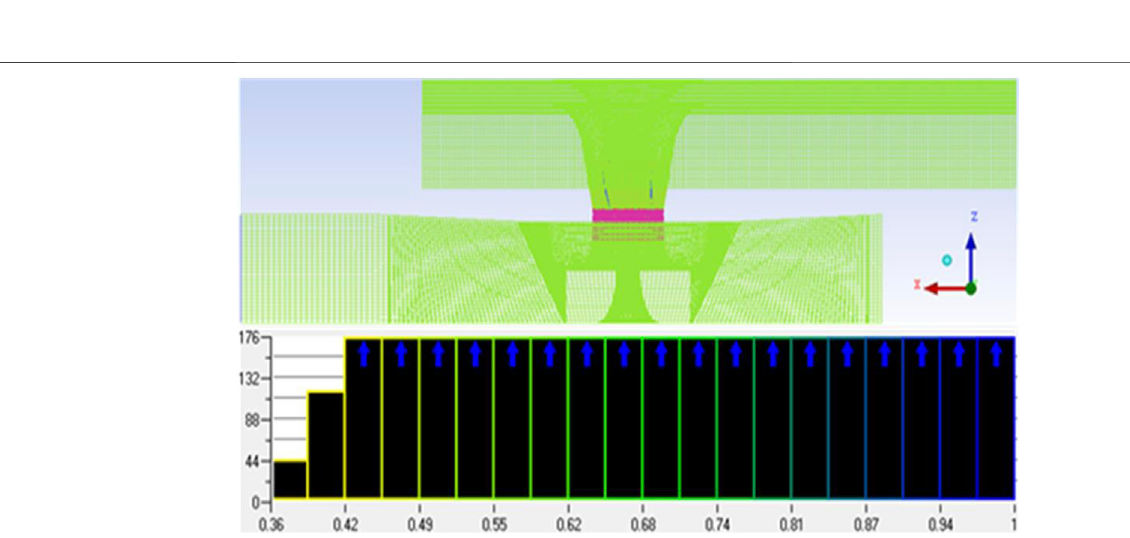
FIGURE 3 | Fluid domain mesh